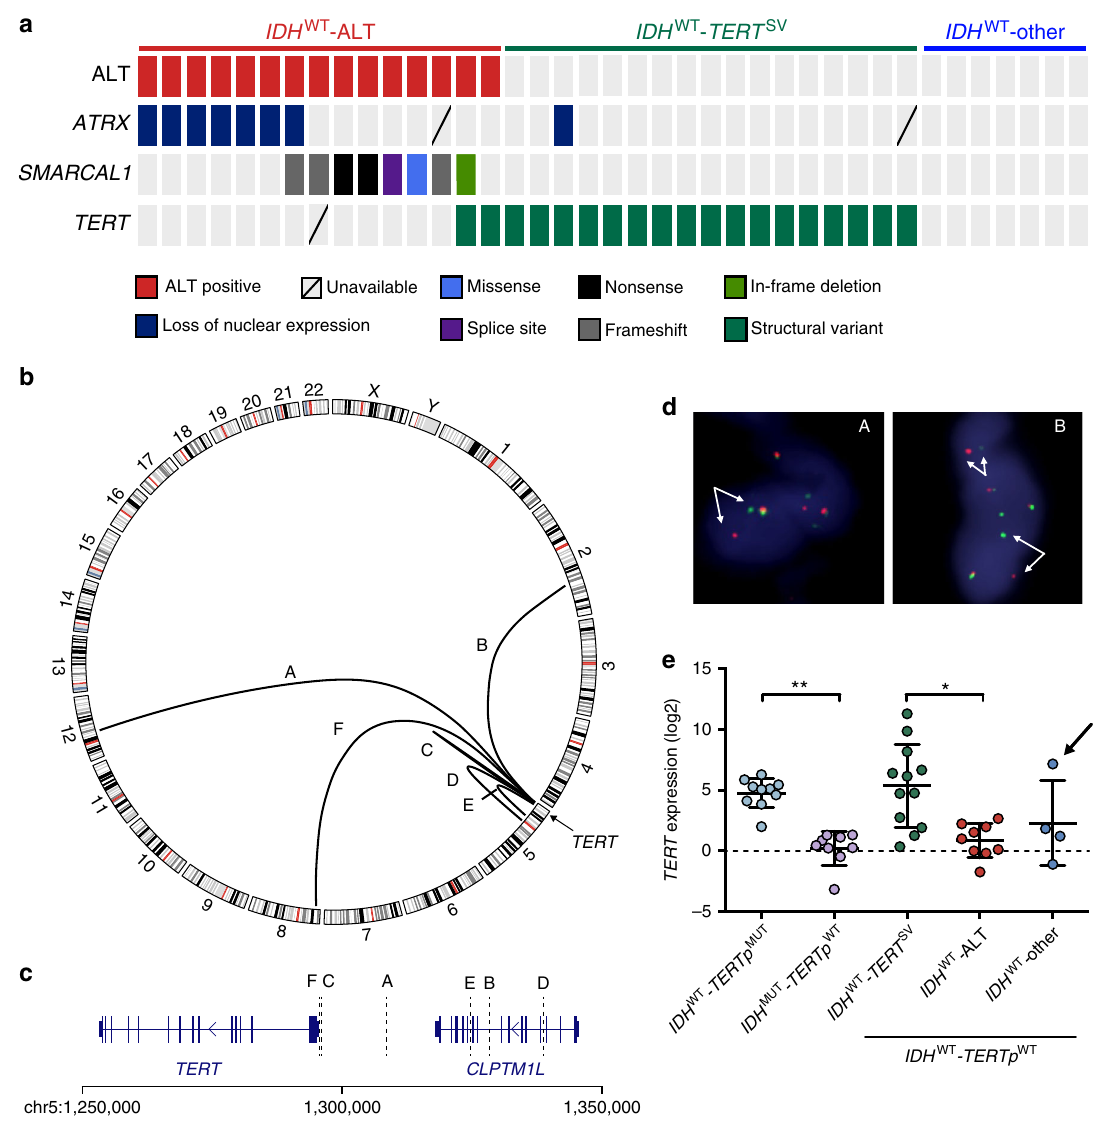
Fig. 2 Inactivating mutations in SMARCAL1 and ATRX , and rearrangements upstream of TERT are frequent in TERTp WT -IDH WT GBMs and related to distinct telomere maintenance mechanisms. a Based on ALT assessment by both telomere FISH and C-circle (dot blot), 38.5% (15/39) of TERTp WT -IDH WT